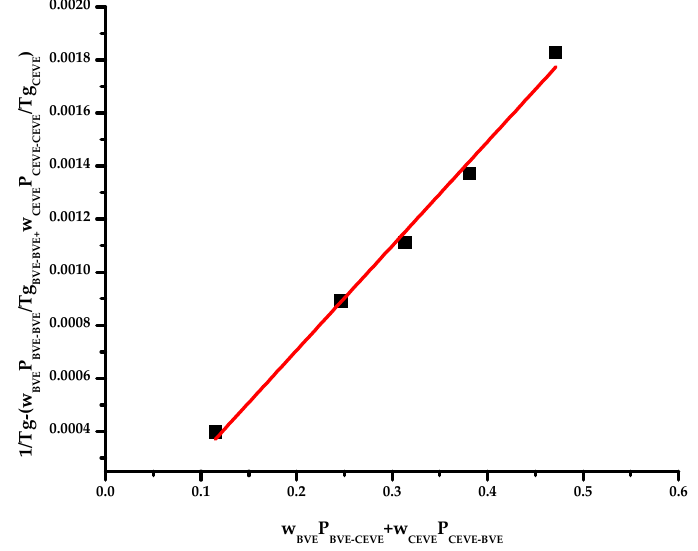
Figure 3. Johnston plot for the statistical copolymers.